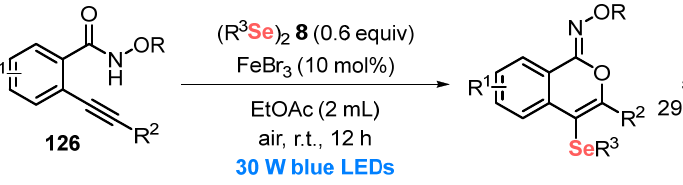
Scheme 71. Visible light ‐ promoted aminoselenylation of alkenes 123 .